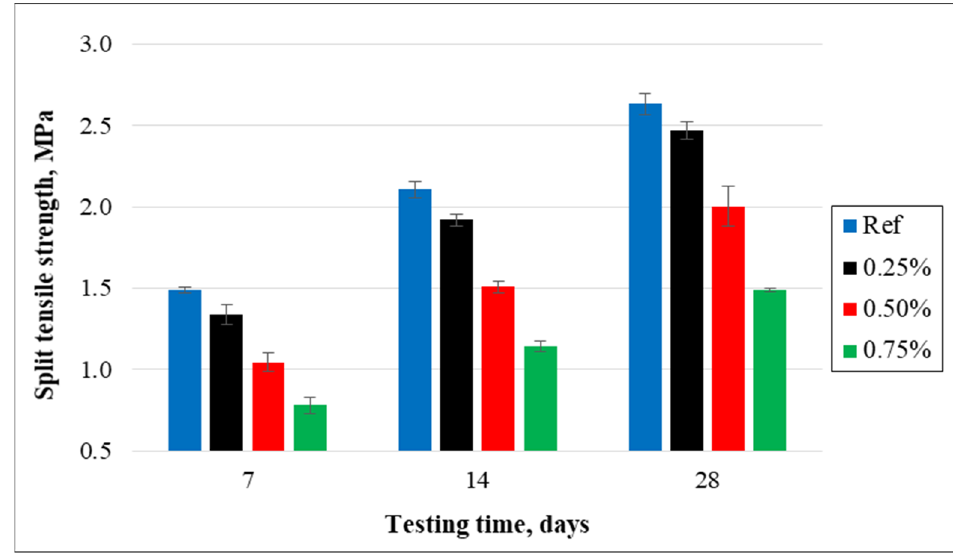
Figure 21. Split tensile strength of concrete specimens containing cut pieces .